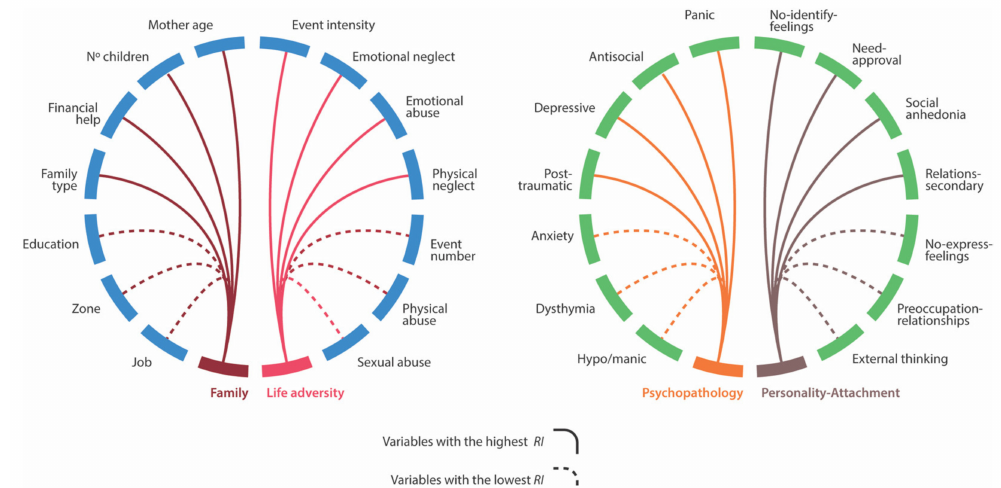
Figure 1. Set of variables resulting from the gradient boosting analyses of family and life adversity variables (left), and of maternal psychopathology and personality-attachment variables (right) that distinguish between the neglected group and the non-neglected control group. The solid/dotted connection lines represent variables that were or were not selected for follow-up confirmatory analyses based on their relative importance values